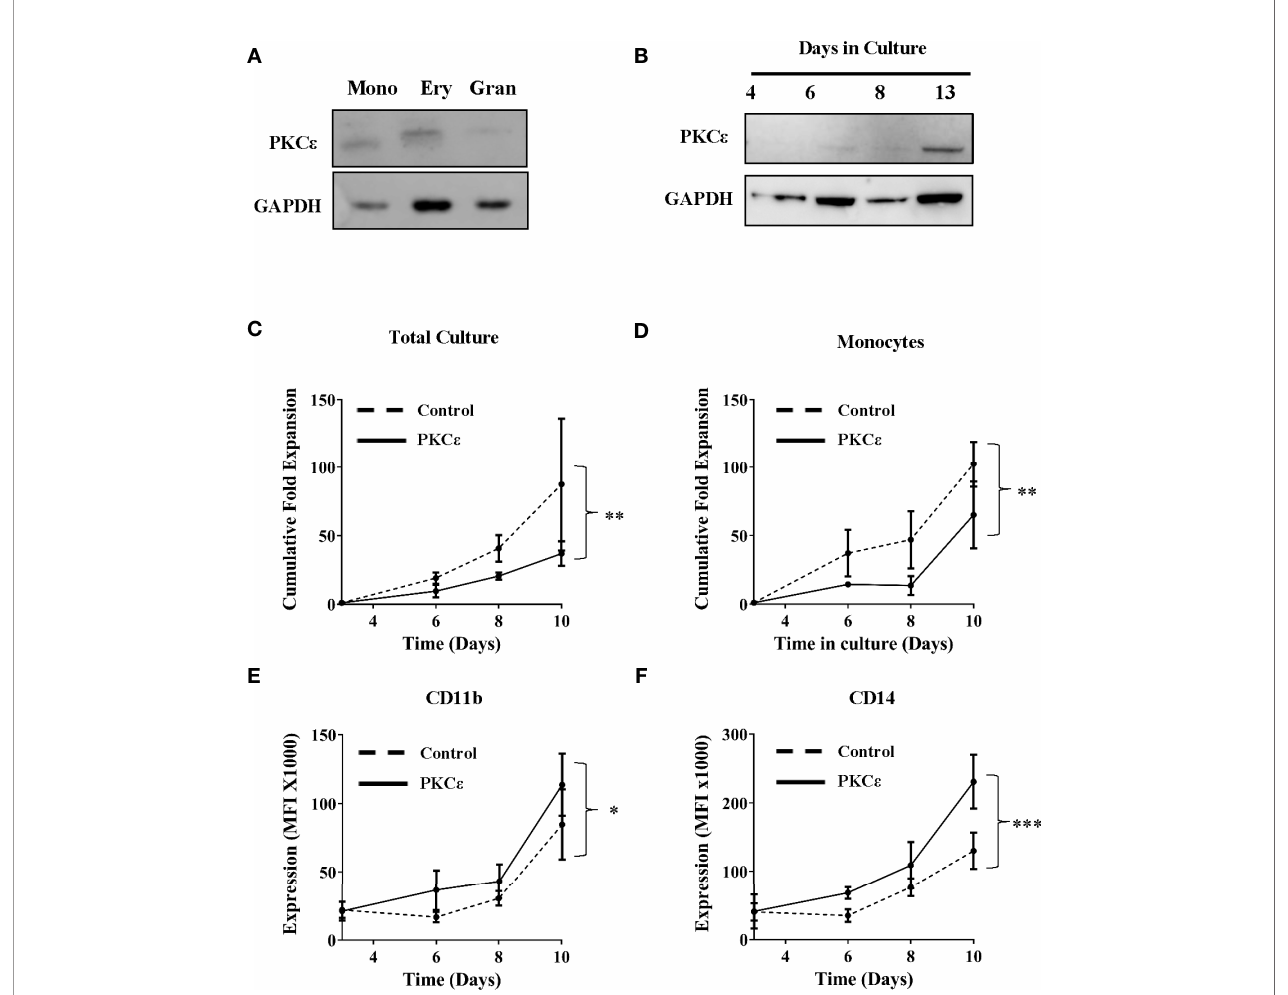
FIGURE 2 | PKC ϵ is expressed throughout hematopoiesis and promotes monocyte differentiation. (A) Western blot showing PKC ϵ (MW-84kDa) protein expression in human umbilical cord blood (CD34 + ) derived monocyte (mono; CD14 high ), erythrocyte (very; CD14 neg CD36 high ) and granulocyte (gran; CD14 low CD36 low ) progenitors. (B) Western blot analysis showing PKC ϵ protein (MW-84kDa) expression in CD34 + HSPC over 13 days of culture where PKC ϵ expression is shown alongside GAPDH (MW-36kDa) expression which was used as a loading control. For densitometry analysis of this western blot see Supplementary Figure 3A . PKC ϵ expression was detected using the Cell Signaling Technologies antibody (22B10; Supplementary Table 2 ) while GAPDH was detected using the ThermoFisher Scienti fi c antibody (GA1R; Supplementary Table 2 ). (C) Cumulative fold expansion of CD34 + HSPC total culture and (D) of monocytic progenitors (CD13 high CD36 high ) transduced with the control or PKC ϵ overexpression constructs. Immunophenotypic analysis of (E) CD11b and (F) CD14 expression (MFI) on transduced monocytic progenitors (CD13 high CD36 high ) over 10 days of culture. Antibodies used for this analysis are outlined in Supplementary Table 2 ; n=4, *p < 0.05, **p < 0.01, ***p < 0.001 using two-way ANOVA with Bonferroni post-test comparison between the control and PKC ϵ overexpression cells at day 10 of